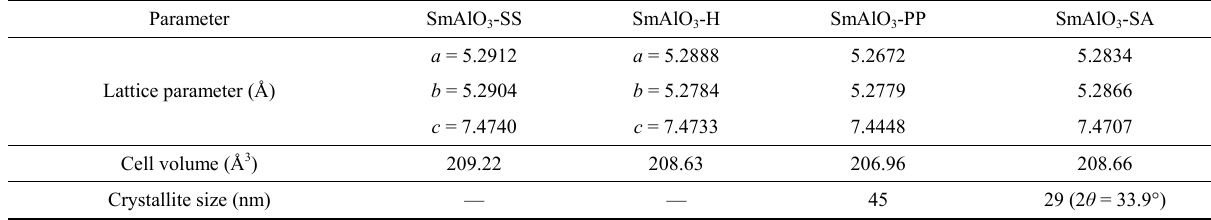
Table 1 Lattice parameters and average crystallite size of SmAlO 3 obtained using solid state (SmAlO 3 -SS),